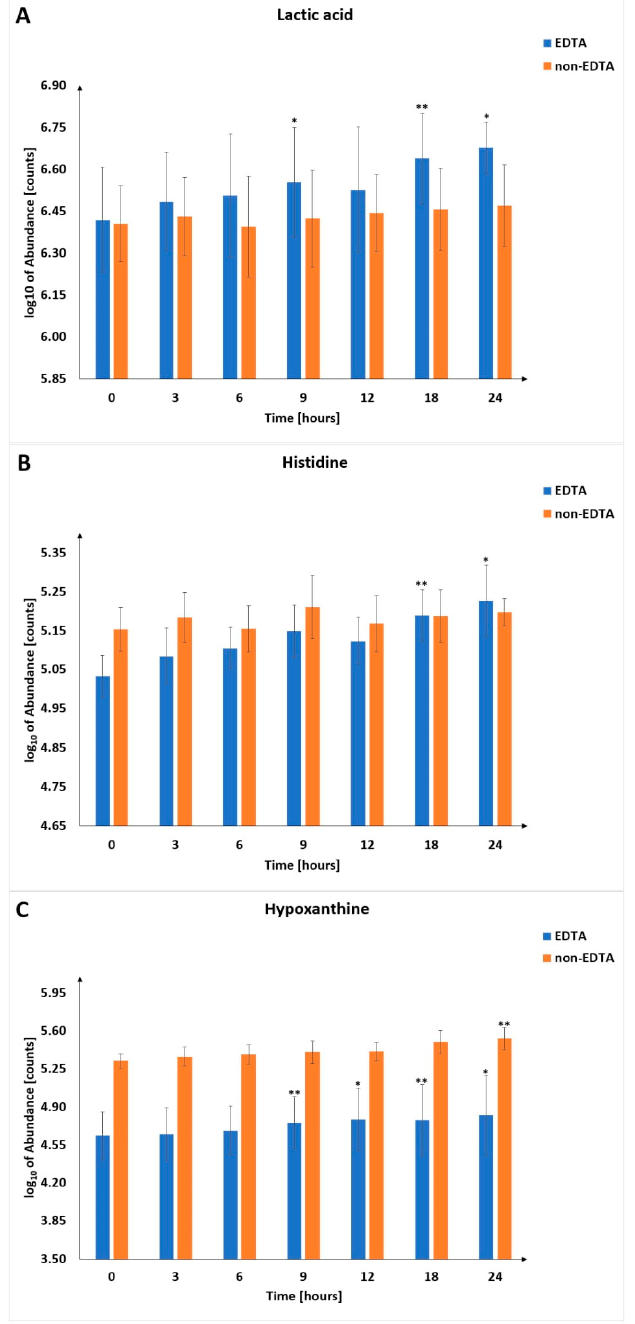
Figure 6. Changes in the level of selected metabolites in different postmortem time intervals. Panel ( A ) shows the trajectory for lactic acid, panel ( B ) shows histidine, and panel ( C ) shows hypoxanthine. *— p -value < 0.05, **— p -value < 0.01.